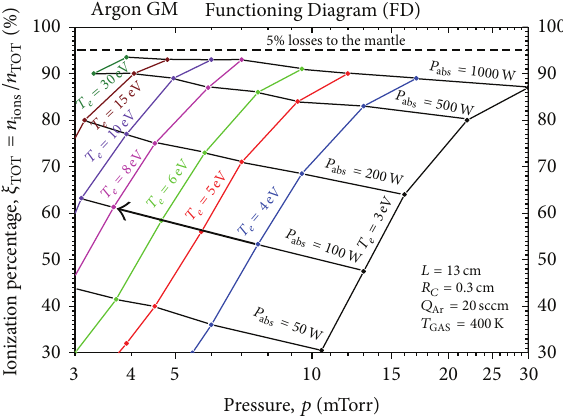
Figure 16: As in Figure 15 but for 20sccm flow